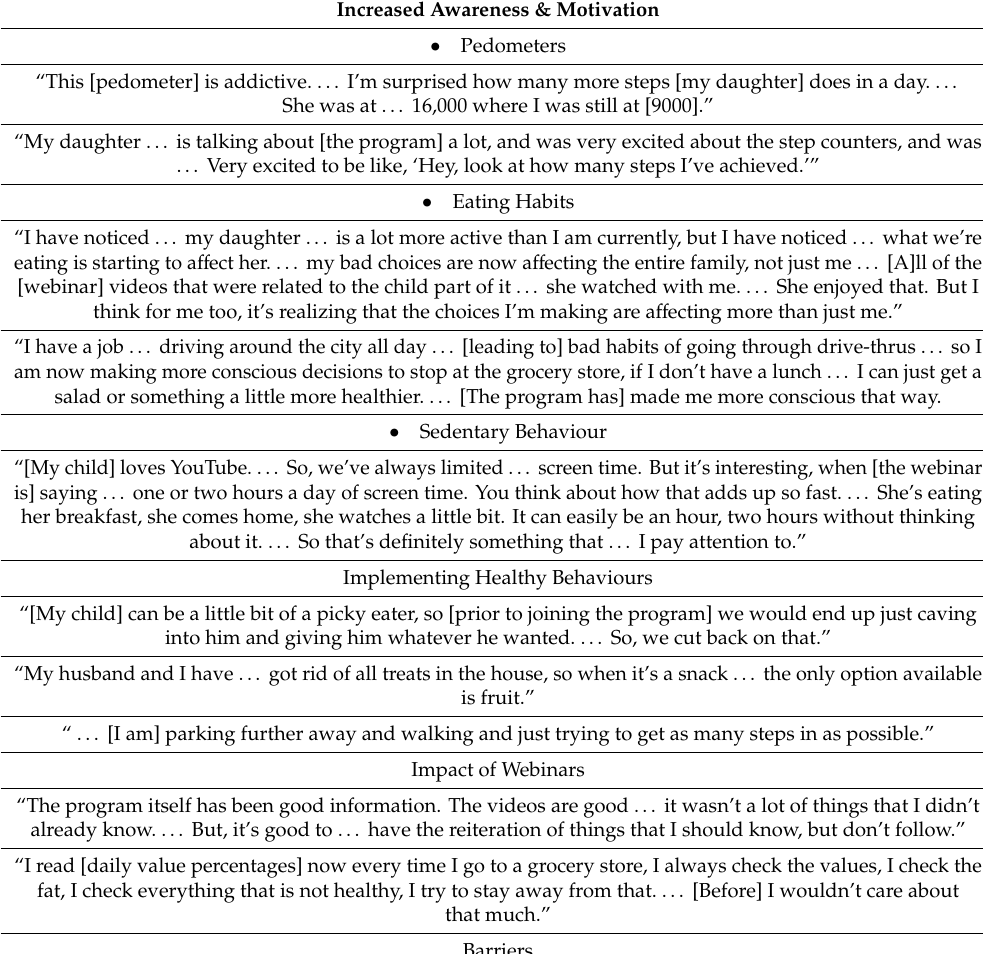
Table 8. Corroborative Quotations for Mid-Intervention Themes and Sub-Themes (Control